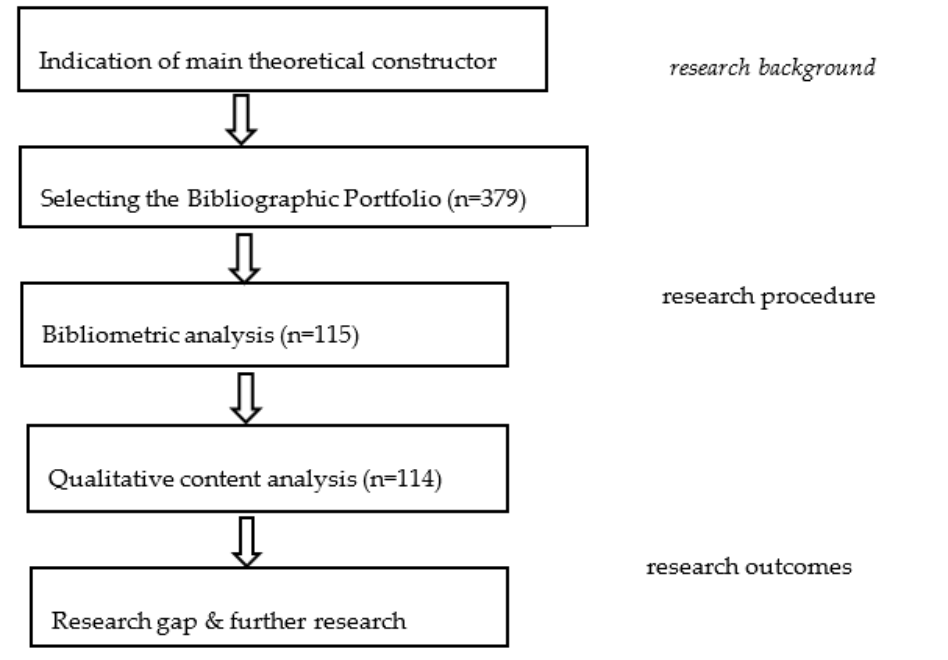
Figure 1. Structured review procedure.